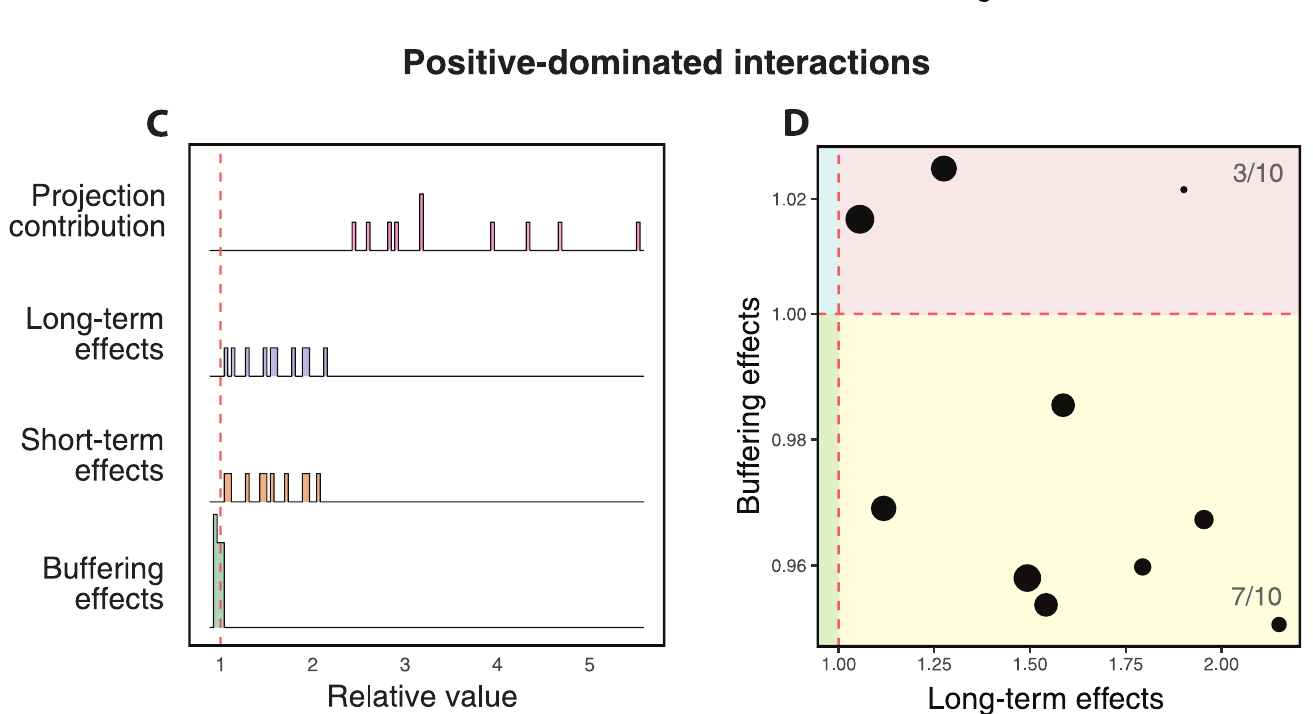
Fig 2. Cartographic representation of long-term and short-term differences among pairs with the same set of third-party species. Panels A and C show the system-level effects on 10 pairs within a randomly-generated five-species system characterized by negative-dominated and positive-dominated interactions, respectively (see text). Rows correspond to the projection distribution ( PC ð Z ; S Þ ), long-term effects ( LE ð Z ; S Þ ), short-term effects ( SE ð Z ; S Þ ), and buffering effects ( BE ð Z ; S Þ ), respectively. Note that each point in the distributions is a different pair within a set of third-party species. For reference, the dashed line shows the value of 1. Recall that the x-axis corresponds to the change in probability of pairwise coexistence with third-party species. Panels B and D illustrate the cartographic representation for all corresponding pairs based on beneficial ( LE ð Z ; S Þ > 1 ) or detrimental ( LE ð Z ; S Þ < 1 ) long-term effects and beneficial ( BE ð Z ; S Þ > 1 ) or